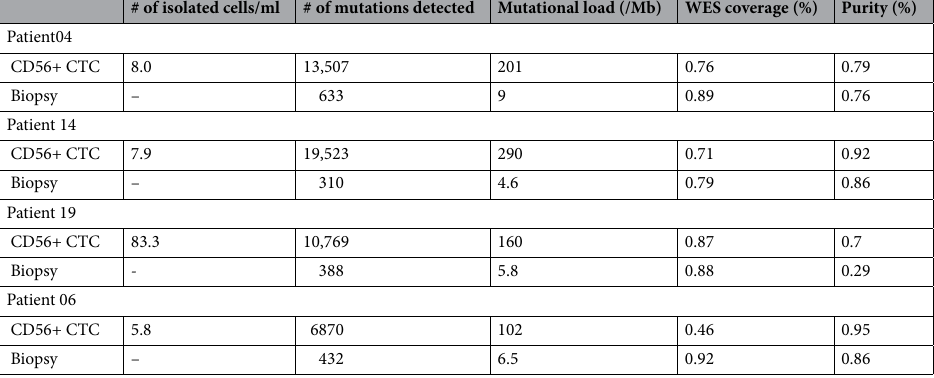
Table 1. Genomic analysis of tumor biopsies and CD56+